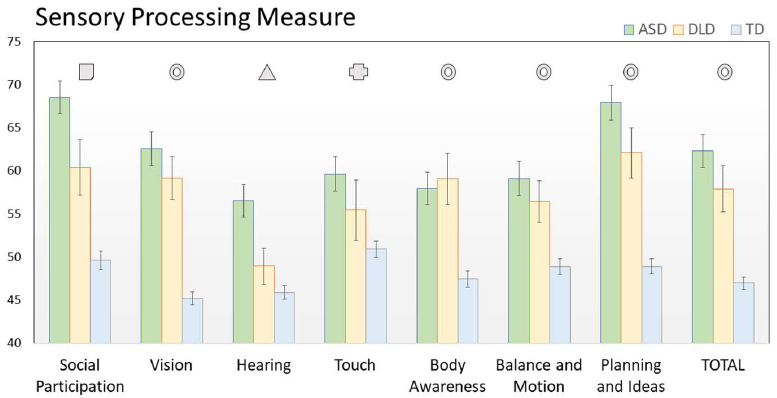
Figure 1. The figure reports the results of SPM subscales across the three groups (ASD in green, DLD in orange, and TD in cyan). Each symbol indicates the pattern emerging by post-hoc comparisons. Circles relate to the subscales in which ASD and DLD detach from TD without differentiating. Triangles indicate the subscales in which ASD children have higher scores than DLD and TD children. Squares indicate the subscales in which all groups differ from each other. Crosses indicate the subscales where only the post-hoc comparison between ASD and TD children was significant.